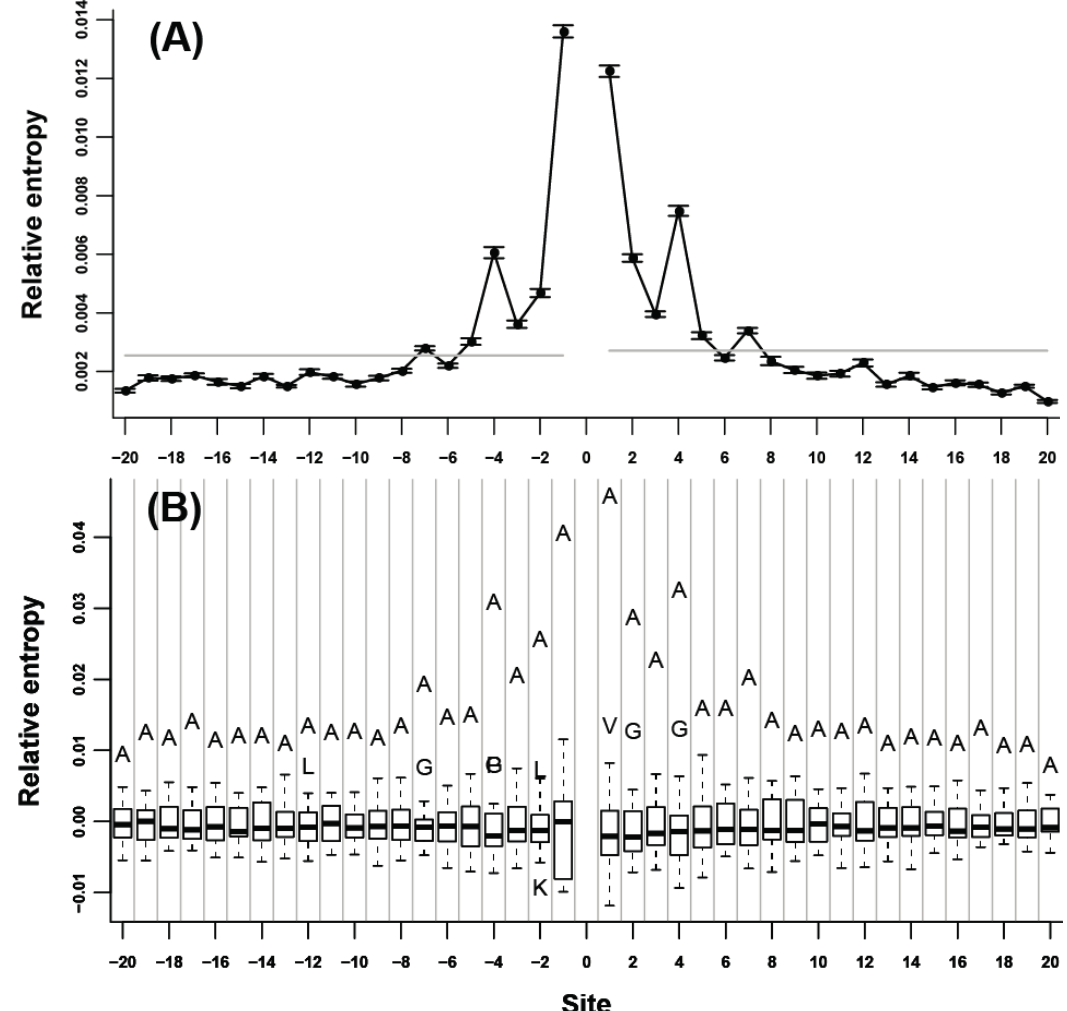
Figure 1. Neighbor preference pattern of the amino acid A. ( A ) Relative entropies of the neighboring sites of A of N - and C -termini. The vertical coordinate represents the value of relative entropy, and the horizontal coordinate represents the relative distance to the 0 site. The flanking sites of N -terminus are indicated by negative numbers and the flanking sites of C -terminus are indicated by positive numbers. The gray lines are the thresholds representing 0.001 significance level. The standard deviation of the relative entropy in each site is indicated by black error bars; ( B ) Boxplot of the 20 relative entropies calculated by ( ) P a ( { , ,..., } a A E Y  ) at each flanking site of the amino acid A. The bold line in ( )log P a 2 ( ) Q a each box represents the median of the 20 values. The top and bottom lines of each box indicate the upper and lower quartiles, respectively. The upper and lower whiskers represent the largest data point which was less than the sum of the upper quartile plus 1.5 times the interquartile range (IQR), and the lowest data point which was greater than the lower quartile minus 1.5 IQR, respectively. In order to determine which amino acids were apparently preferred (or not preferred) in the neighboring sites, the outliers were represented by the corresponding one letter codes of amino